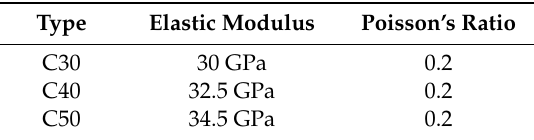
Table 2. Elastic properties of some common concretes.